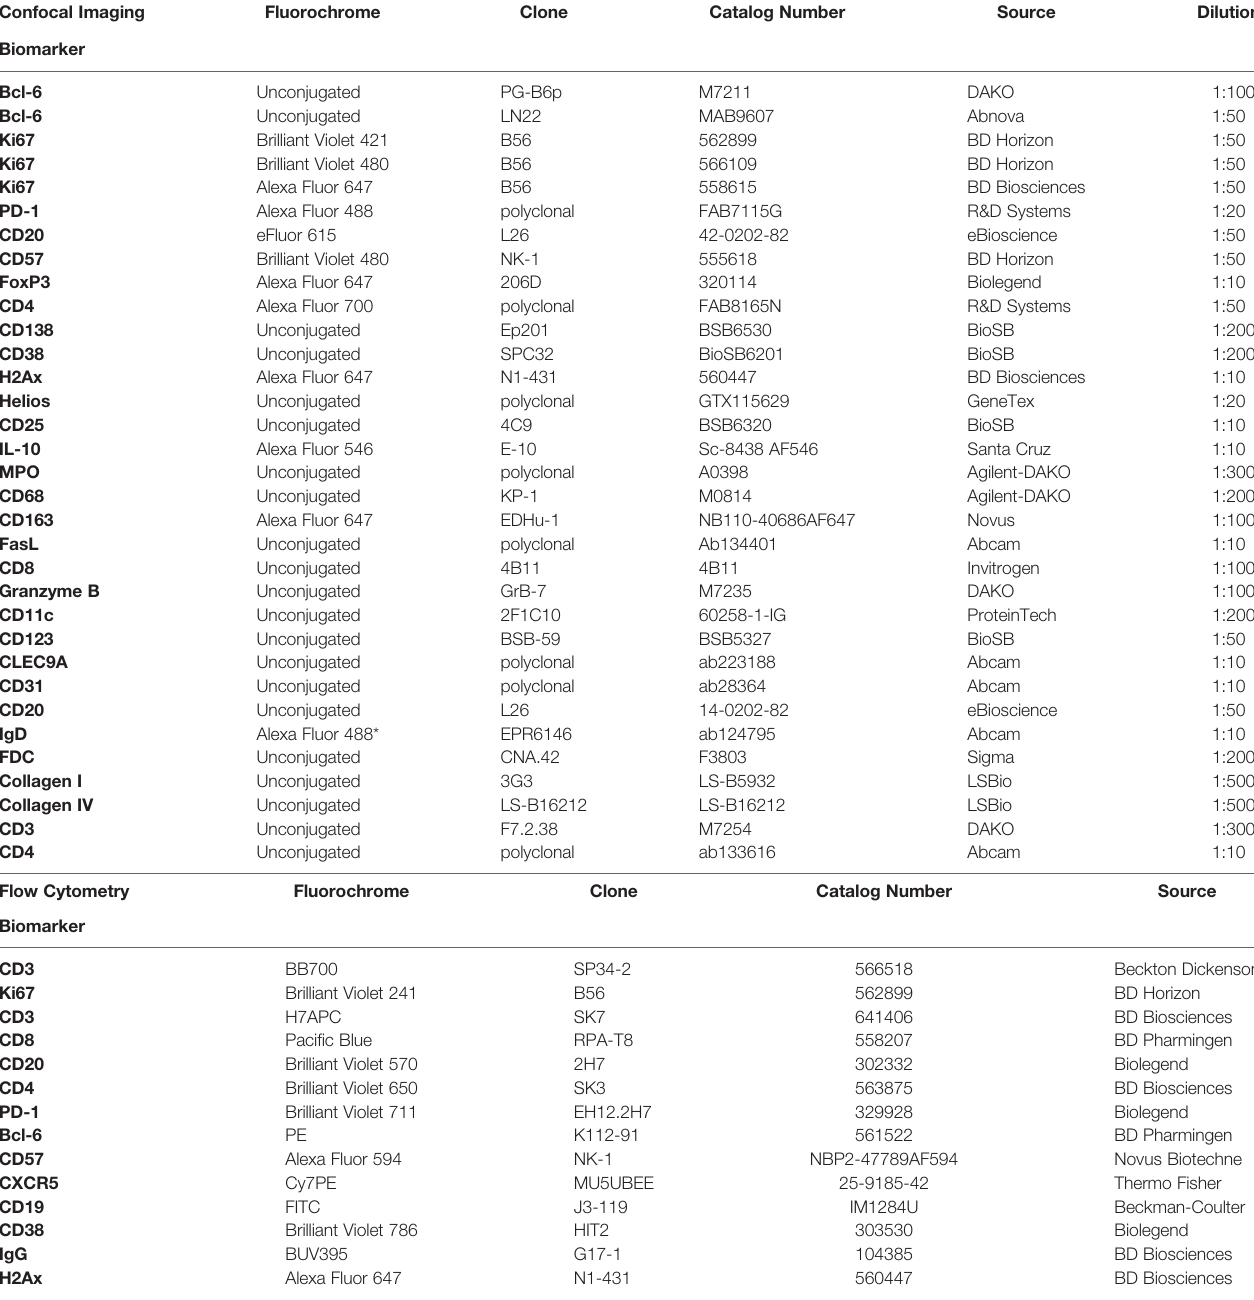
TABLE 1 | Antibodies used for confocal imaging and fl ow cytometry. Confocal